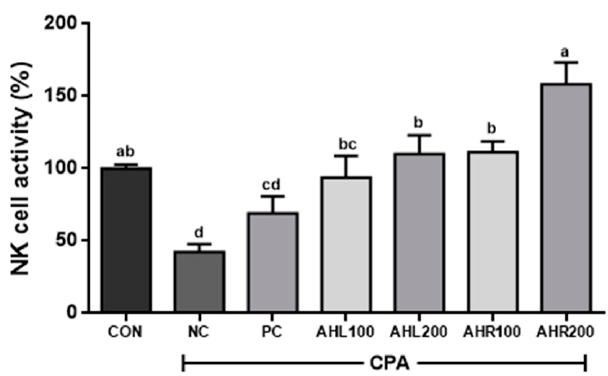
Figure 9. Effects of A. hookeri leaves (AHL) and A. hookeri roots (AHR) extracts on NK cell activities against Yac-1 in splenocytes of C57BL/6 mice immunosuppressed by CPA. CON, normal control group; NC, negative control group; PC, positive control group; AHL100, AHL extract 100 mg/kg BW; AHL200, AHL extract 200 mg/kg BW; AHR100, AHR extract 100 mg/kg BW; AHR200, AHR extract 200 mg/kg BW. Data was presented as the mean ± SEM (n = 12). a–d Different letters are significantly different at p < 0.05.